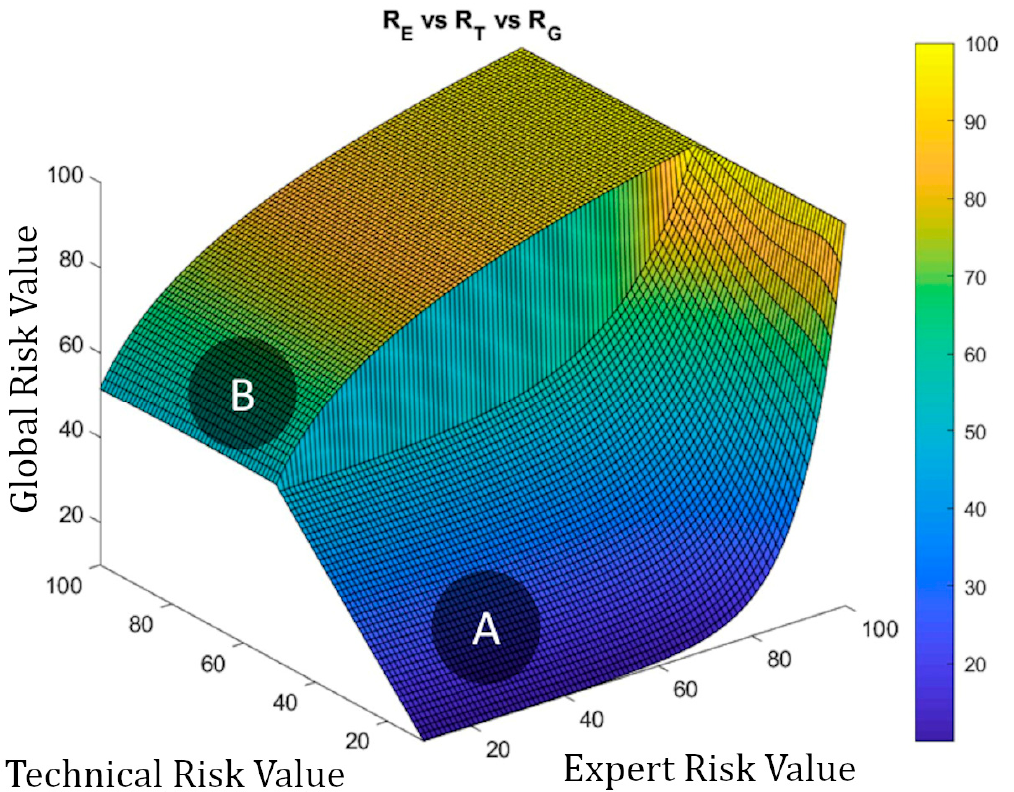
Figure 14. Global Risk surface.